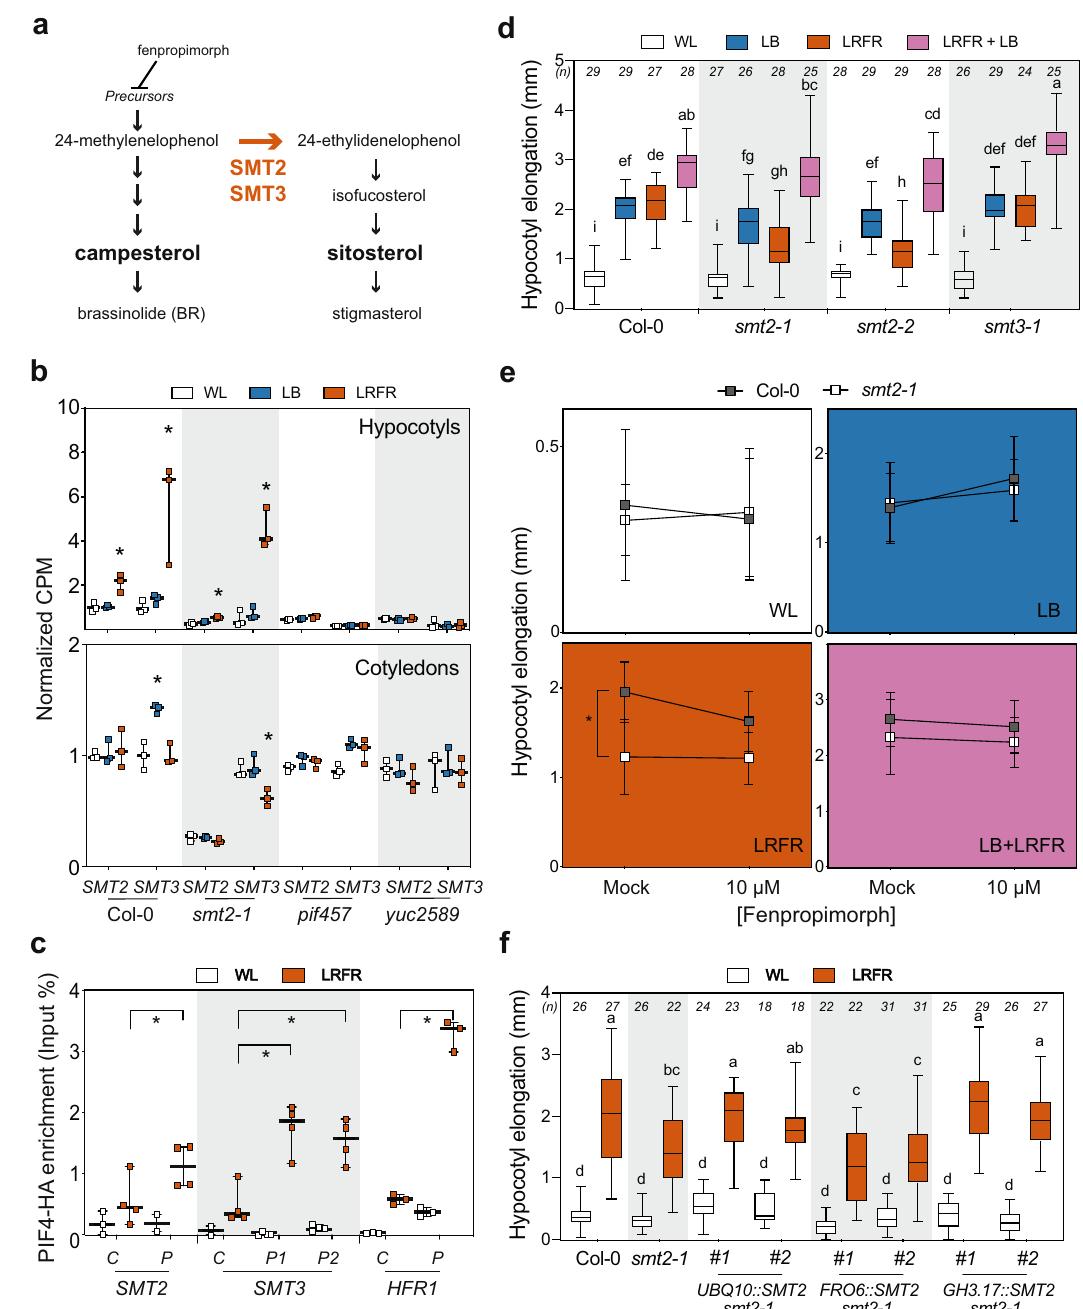
Fig. 4 | SMT2 is required locally for LRFR-induced hypocotyl elongation. a A simpli fi ed representation of sterol biosynthesis pathway in Arabidopsis 46 . b NormalizedCPM(countspermillion,normalizedtoCol-0averageinWL)of SMT2 and SMT3 in the indicated genotypes and conditions (data from RNA-seq). c PIF4- HA binding to the promoter of the indicated genes. PIF4-HA enrichment is quan- ti fi ed by qPCR and presented as IP/Input. Control — C, Peak — P. d – f Hypocotyl elongation of the indicated genotypes. d , f The horizontal bar represents the median; boxes extend from the 25th to the 75th percentile, whiskers extend to showthedatarange. b , c Eachdatapointindicatesbiologically( b )ortechnically( c ) independentsamples,thehorizontalbarrepresentsthemedian,whiskersextendto show the data range. e Data are means±SD with a regression line. Different letters